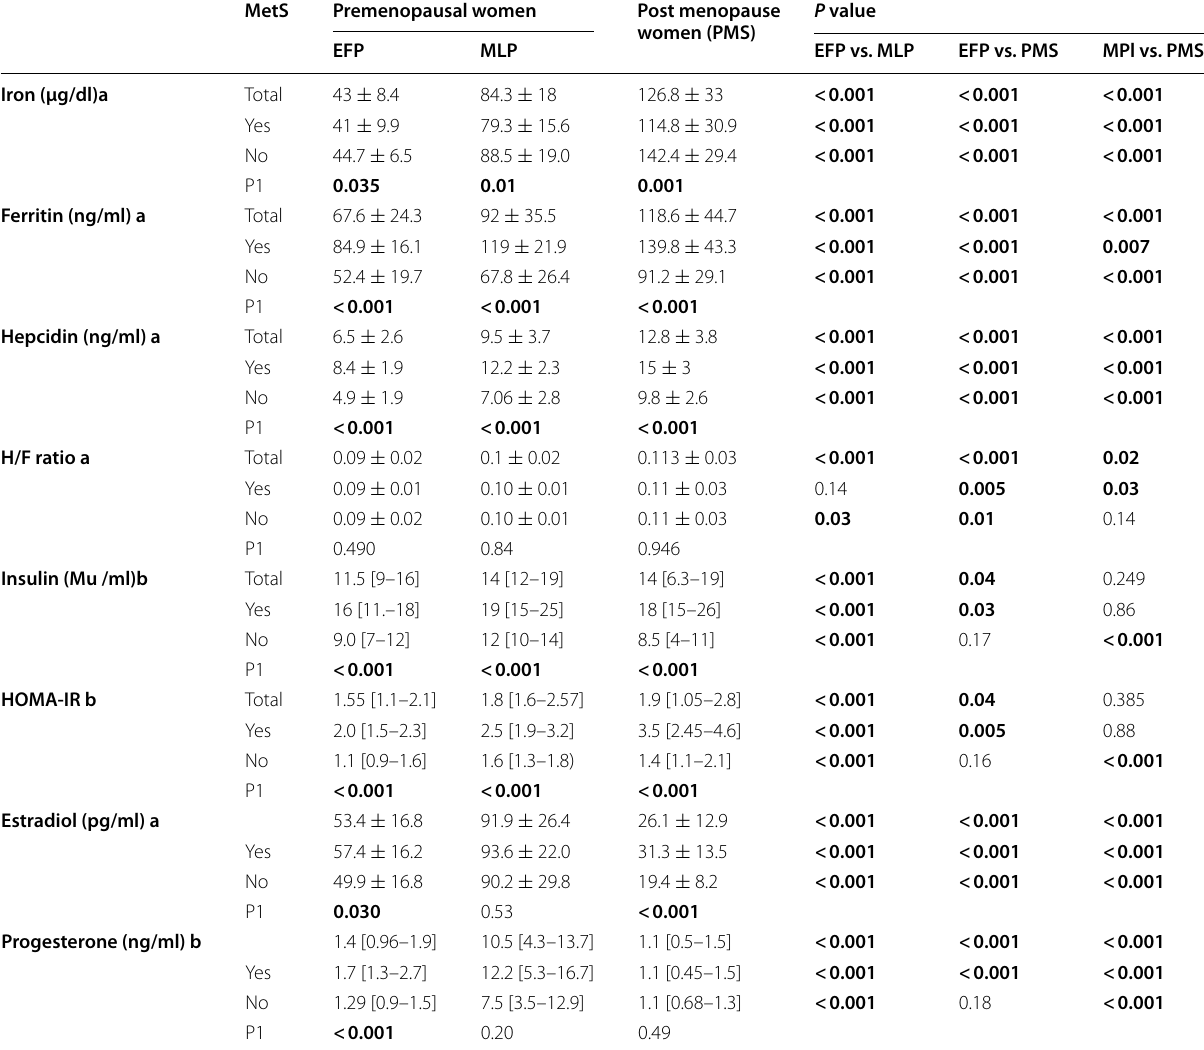
Parametric and non- parametric quantitative data are expressed as Mean Mann-Whitney between EFP and MLP vs. PMS and using paired samples T and Wilcoxon signed rank test between EFP vs. MLP respectively. P1 compared metabolic versus non-metabolic within the same phase or state. Significant level is at p value < 0.05 and written in